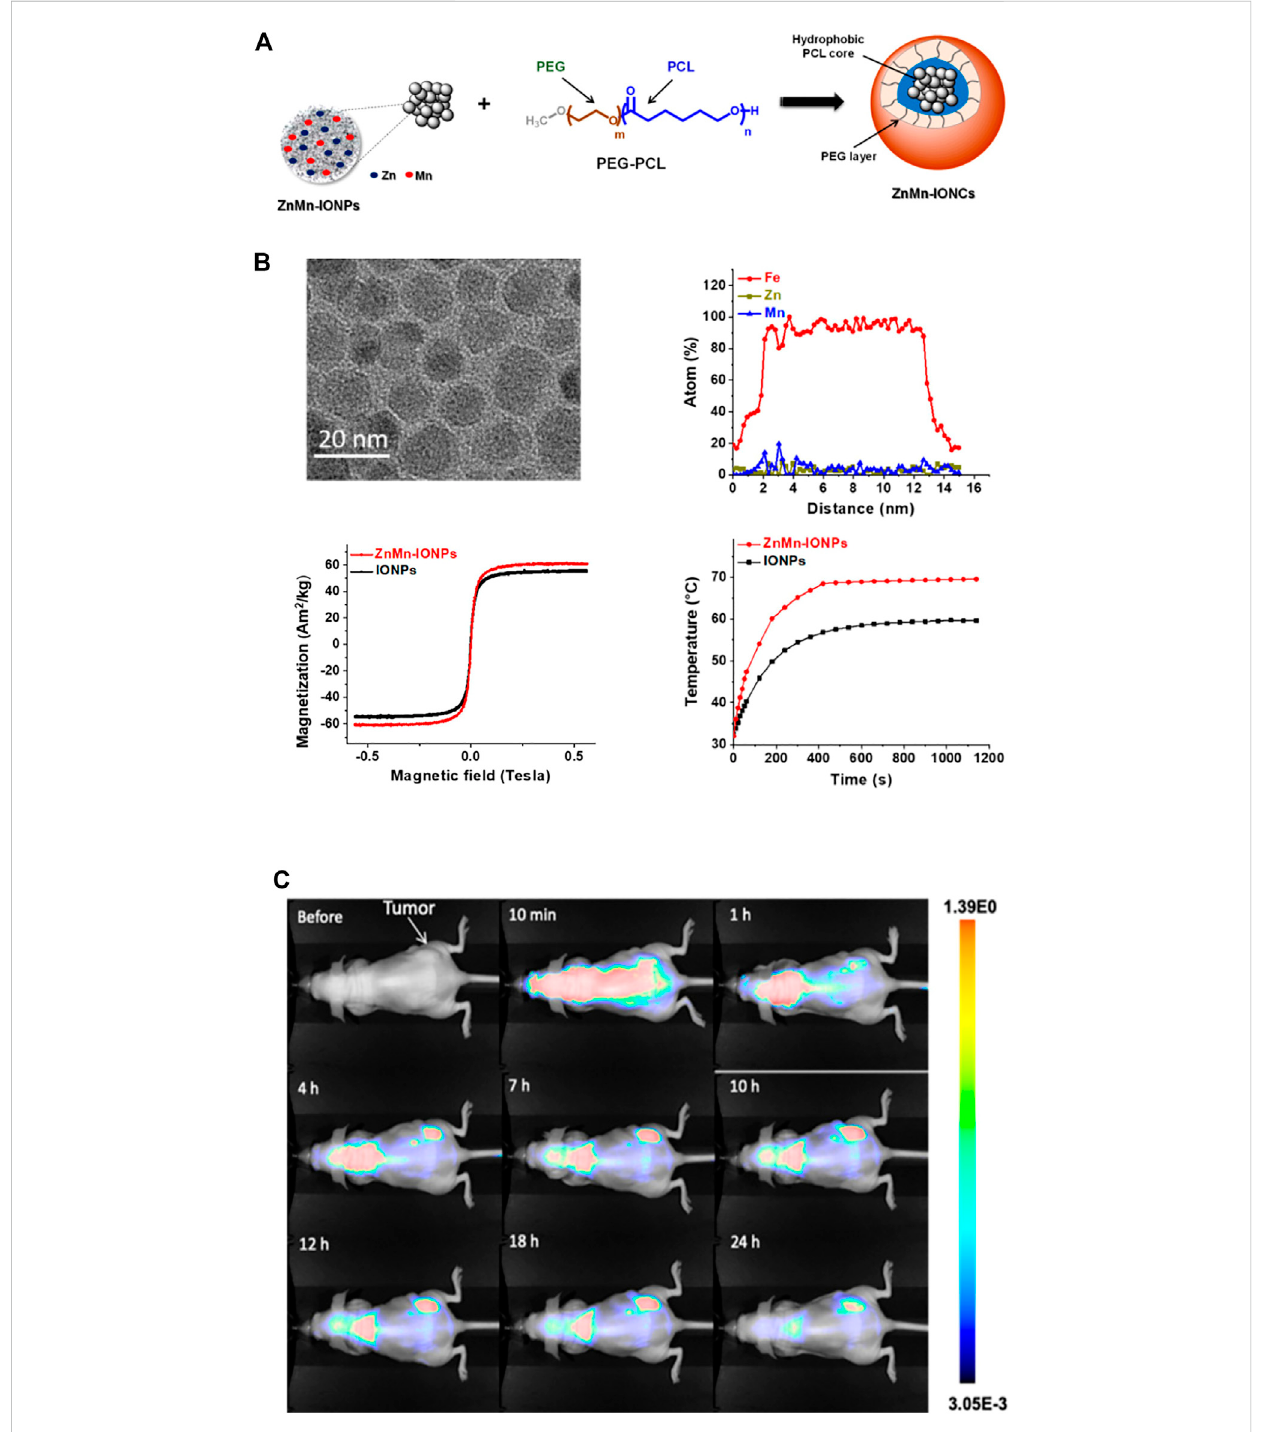
FIGURE 6 Biological applications of magnetic nanoparticles (MNPs). (A) Iron oxide nanoparticles with Zn and Mn were encapsulated into a nanocarrier. (B) Enhanced heating ef fi ciency was achieved upon exposure to an alternating magnetic fi eld. (C) In vivo evaluation of the nanoparticles suggested that ZnMn-IONCs started to accumulate in tumors. The fl uorescence intensity in the tumors was higher than that the liver, kidneys, spleen and